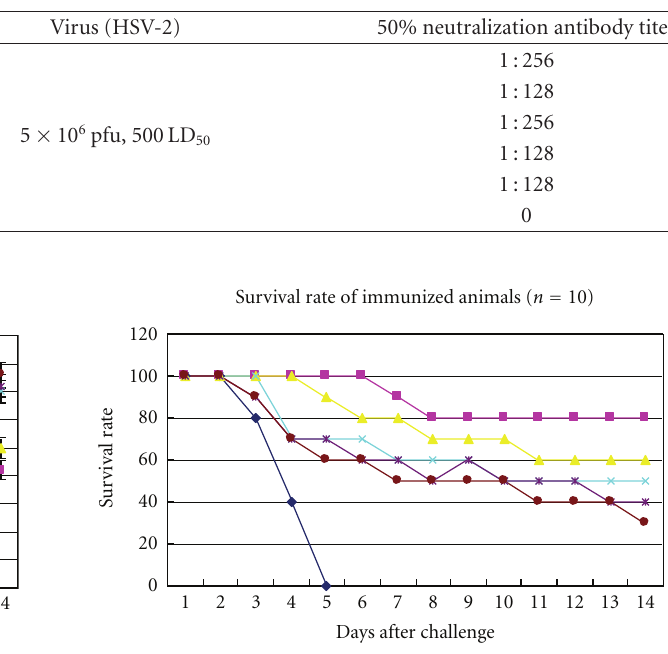
Table 4: Neutralization activity of the antisera to the five epitopes.